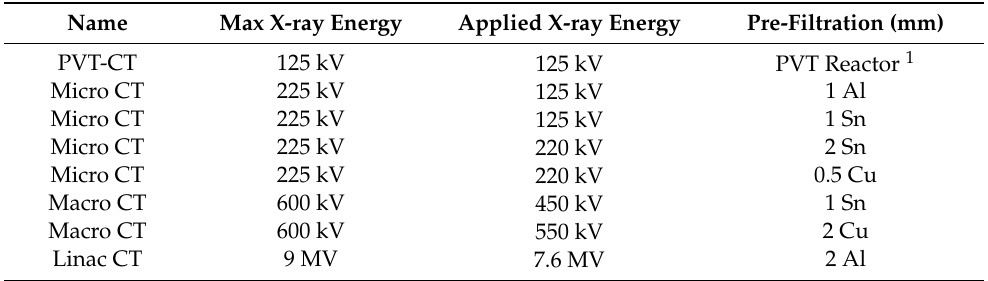
Table 1. The applied computed tomography systems and parameters of the di ff erent